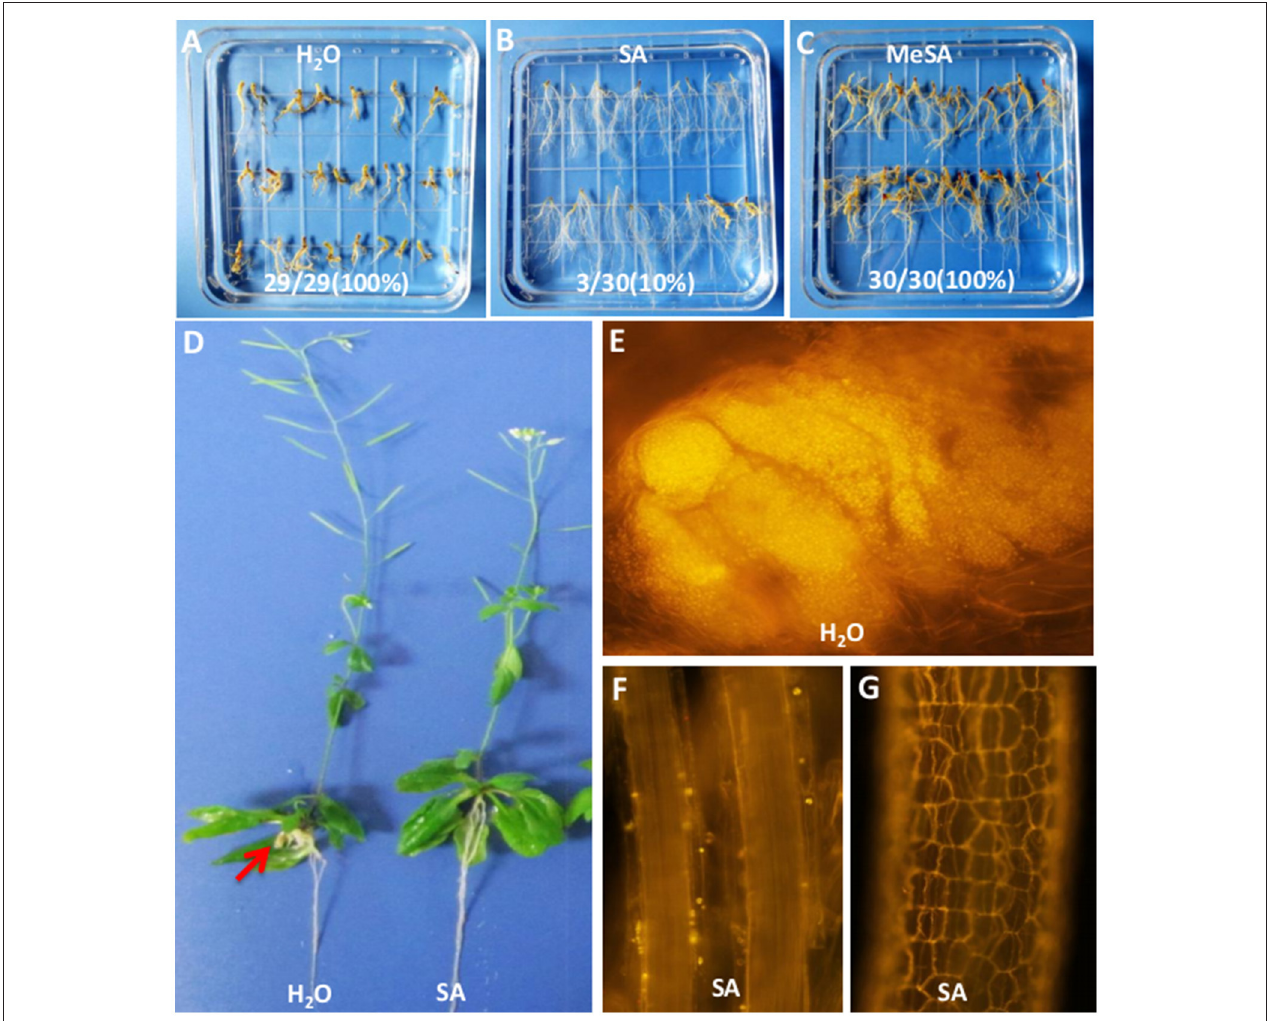
FIGURE 5 | Effect of SA treatment in the pot on gall reduction in 3-week-old infected plants. (A–C) Gall phenotype of Arabidopsis Col-0 infected with P. brassicae for 21 days in 3 different treatments, including H 2 O (left), SA 2.5 × 10 − 5 mol/L for 3 times (middle), and 2.5 × 10 − 5 mol/L MeSA for 3 times (right). The number on the picture showed the gall formation events. (D) Images of whole plants of Arabidopsis Col-0 infected with P. brassicae for 21 days and treated with SA 2.5 × 10 − 5 mol/L for 3 times (right) or not (left). (E) Nile red staining for infected Col-0 clubroots. (F,G) Nile red staining for infected Col-0 clubroots treated with